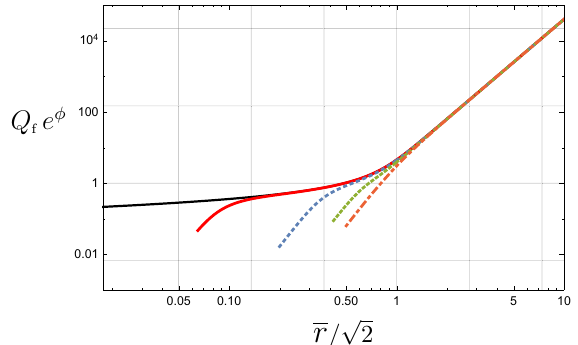
Figure 5 . Radial profile of the dilaton for solutions with the smallest value of r end) for different values of √ 2 N